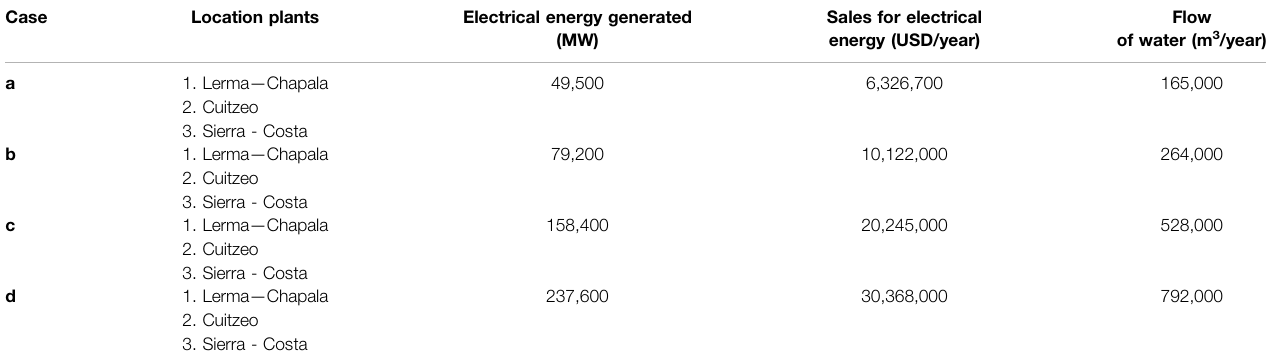
TABLE 2 | Total fl ow of new species used in biofuel production.